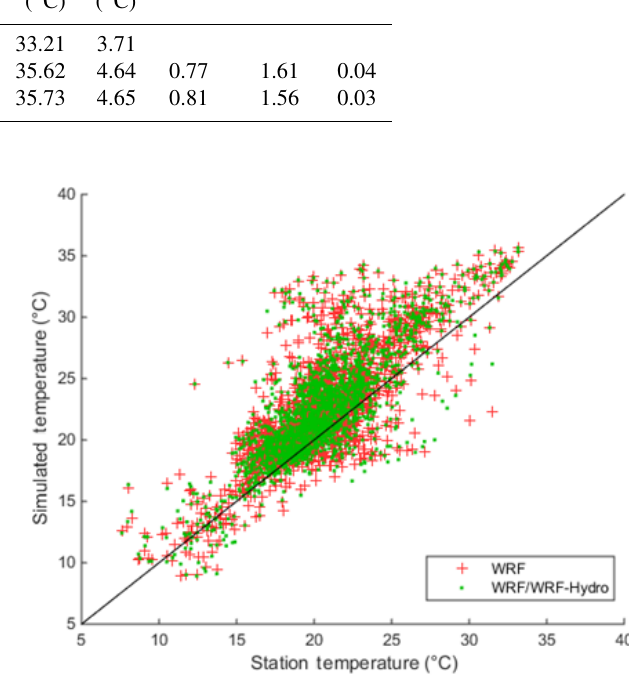
Figure 6. Scatterplot of 2m temperature from WRF and WRF– WRF-Hydro simulations versus station observations across the